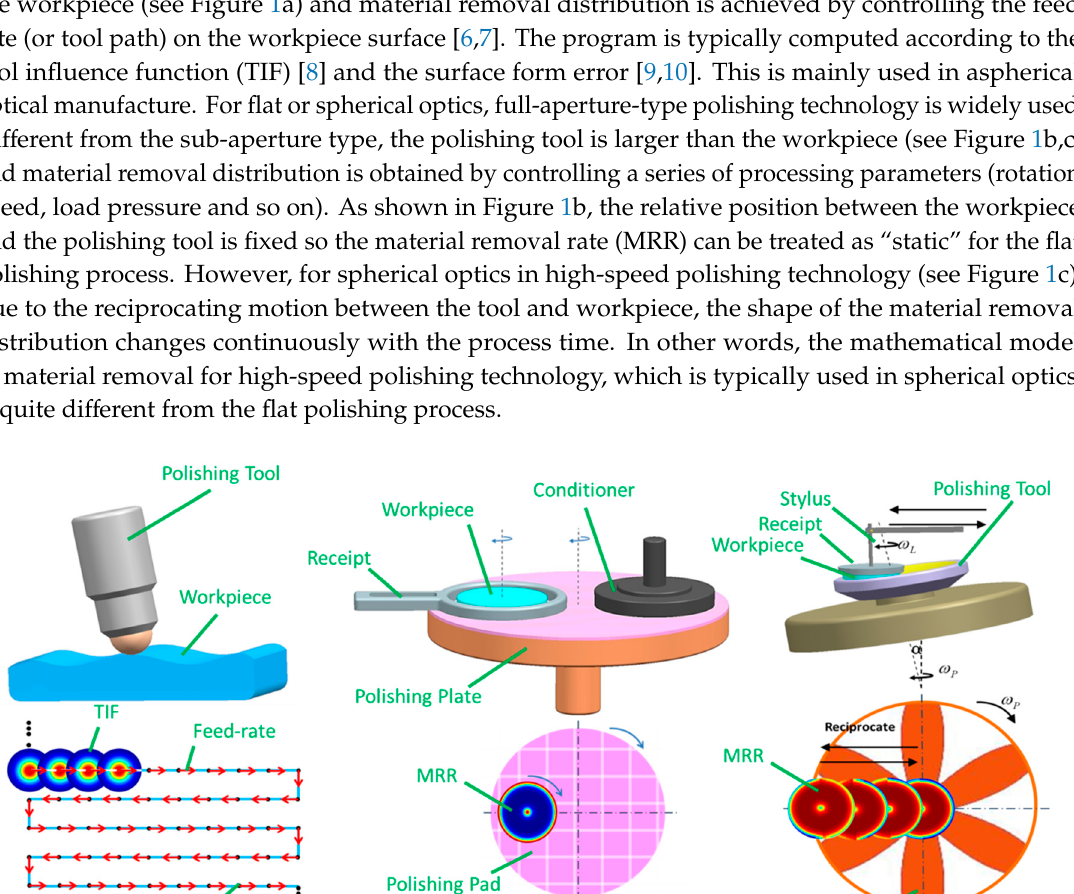
Figure 2. Framework of this paper.